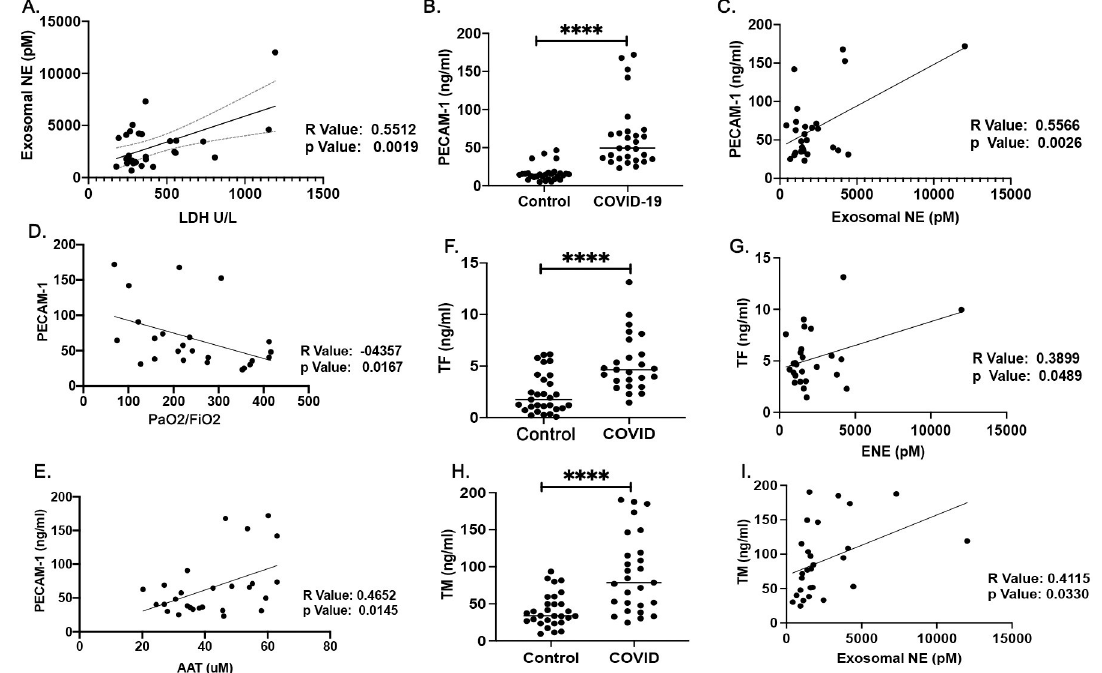
Fig 4. Correlations among plasma exosome associated neutrophil elastase (NE) and endothelial injury in the SARS-CoV2-mediated ARDS patients. (A) The correlation of plasma levels of exosome associated NE levels of LDH in SARS-CoV2 patients. (B) Soluble PECAM-1 plasma levels of SARS-CoV2 patients compared with healthy controls. (C) The correlation of plasma soluble PECAM-1 values with plasma exosome associated NE. (D) Negative correlation of PaO2/FiO2 ratio with soluble PECAM-1 values and (E) correlation between the plasma soluble PECAM-1 values and plasma levels of AAT in COVID-19 patients. (F) Plasma levels of Tissue Factor (TF) and (H) Thrombomodulin (TM) in SARS-CoV2 patients compared with healthy controls. (G) The correlation of plasma TF and (I) TM values with plasma exosome associated NE. ���� p < 0.0001(two-tailed Mann-Whitney U test, Pearson correlation coefficients, two-tailed student’s